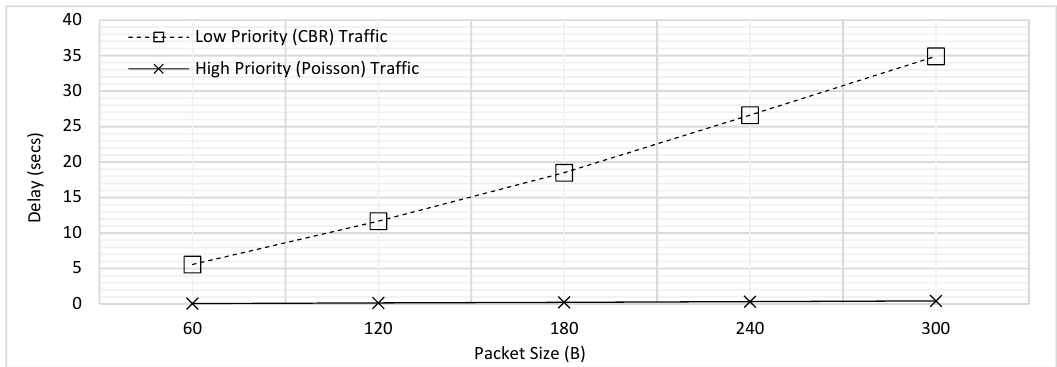
Figure 10. Delay for Prioritization using Fragmentation (Fragment Size = 1B).